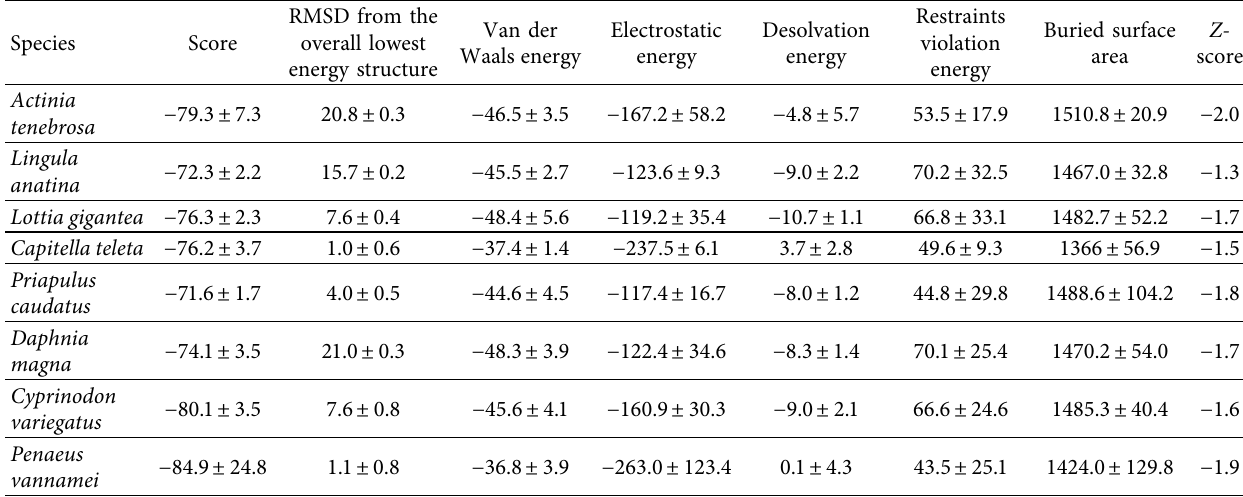
Figure 9: Protein-protein interaction of Rab7 generated from STRING Table 3: Docking information of Rab7 protein sequences of different species.